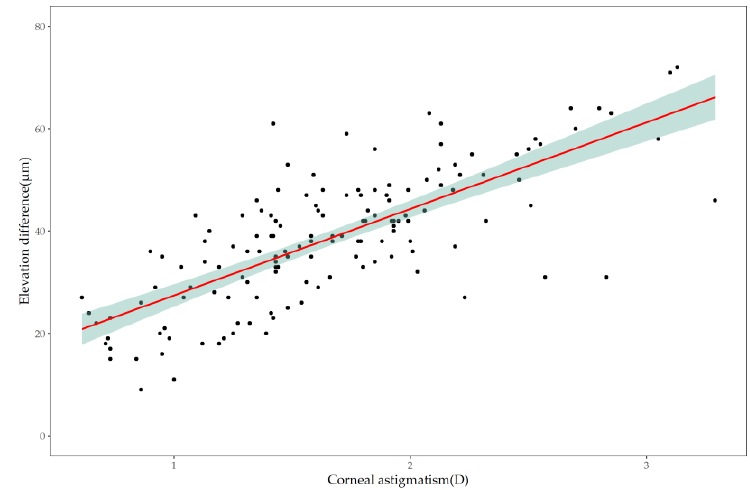
Figure 4. Scatterplot showing the correlation between corneal astigmatism and the average elevation difference at 8 mm chord length of the cornea, with linear trend (red line) and the confidence interval (green shade).